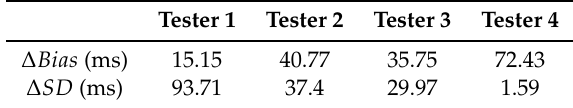
Table 4. Bland–Altman analysis on resting testers in Spot 1.